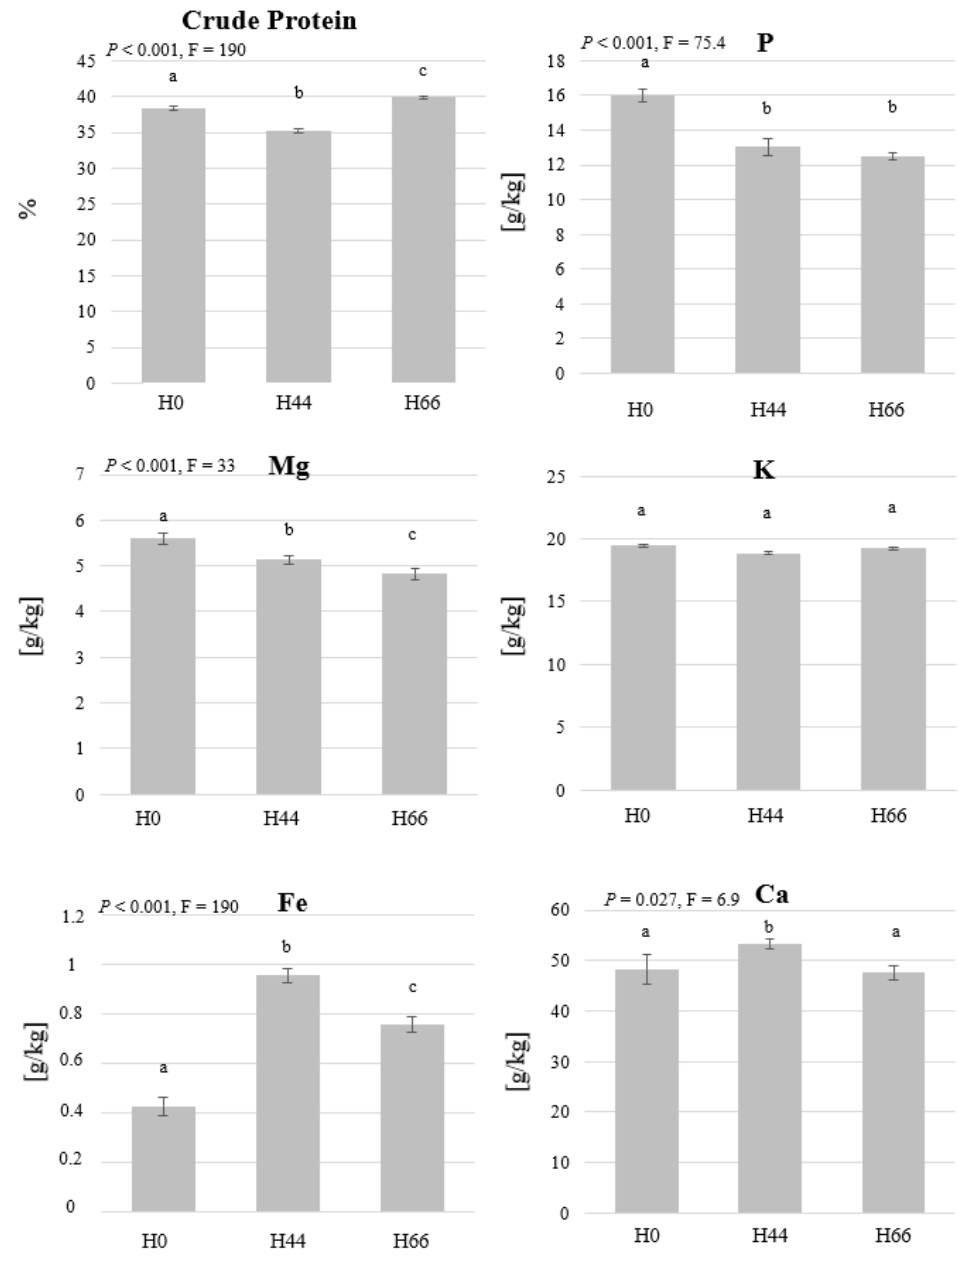
Figure 3. The mass fraction of protein, P, Mg, K, Fe, and Ca in dry black soldier fly larvae (BSFL) grown on substrates that contain different ratios of hemp material. BSFL were grown on substrates with 0% hemp (H0), 44% hemp (H44), or 66% hemp (H66). Shown are the means and the standard deviations of the measured mass fractions. One ‐ way ANOVA (n = 3, p < 0.05) revealed significant differences between the treatments and the significant groups are represented by different letters.